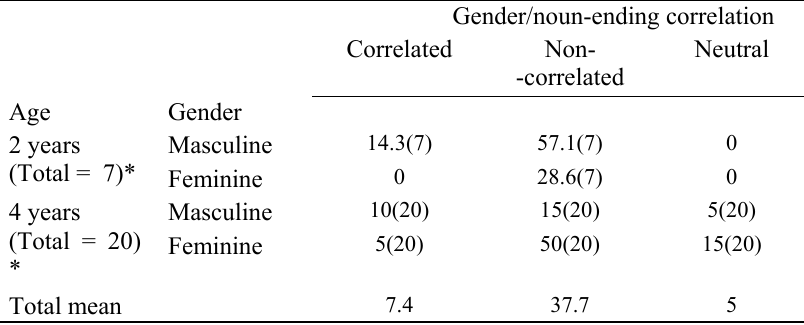
Table IV: Percentage target responses with noun-ending alterations in BP